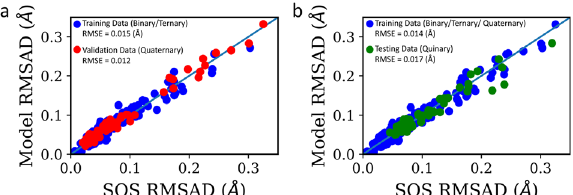
Fig. 3 Illustration of the difference in the fi lling energy of the d -bands with a unimodal and bimodal electronic DOS. a The fi lling fraction is close to the band center. b The fi lling fraction is close to the band edge. The position of the Fermi level is represented by the red dashed line.